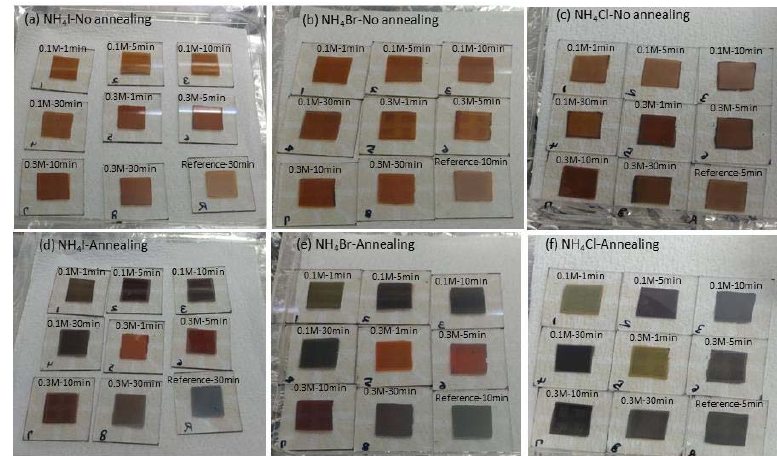
Figure 3. Optical images of CH 3 NH 3 PbI 3 ‐ x Cl x layers prepared with ( a ) NH 4 I, ( b ) NH 4 Br, and ( c ) NH 4 Cl before annealing process and ( d ) NH 4 I, ( e ) NH 4 Br, ( f ) NH 4 Cl after annealing process. The color change occurred after annealing.